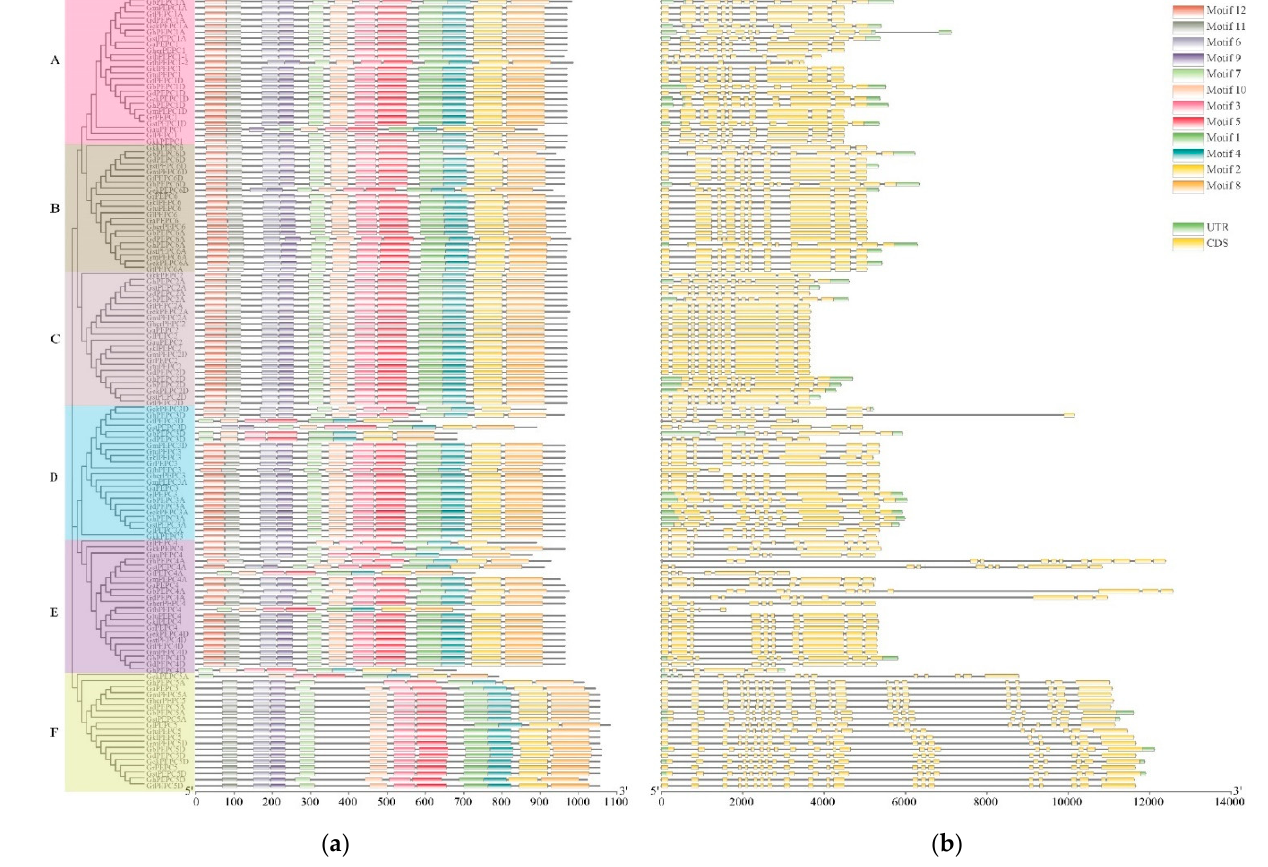
Figure 3. The exon–intron structures and conserved motifs of PEPC. The structure triplet of cotton PEPC proteins. The length of the proteins and DNA sequence was estimated using the scale at the bottom, black line indicated the non-conserved amino acid or introns. ( a ) Phylogenetic relationship of cotton PEPC protein; ( b ) The conserved motifs and the gene structures of PEPC gene family.